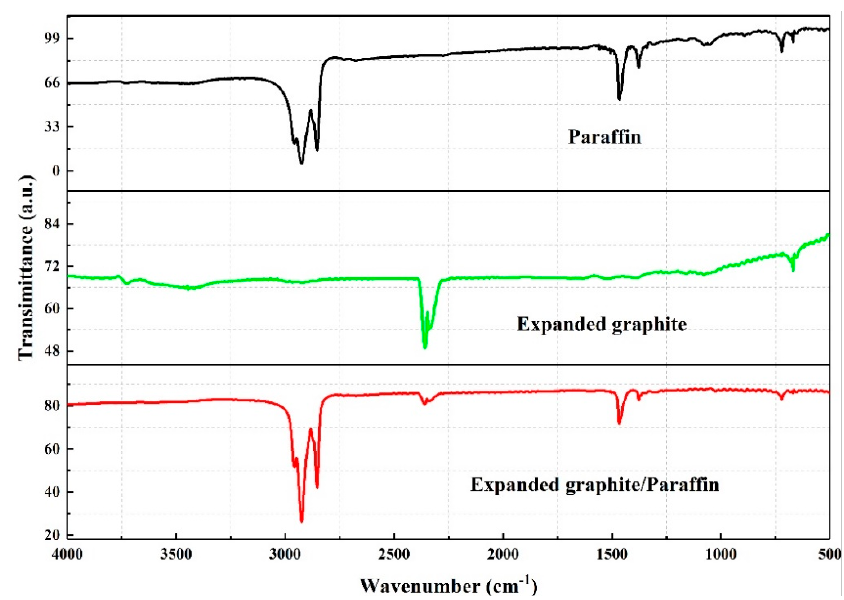
Figure 8. FT-IR spectrum of paraffin, EG, and expanded graphite/paraffin.